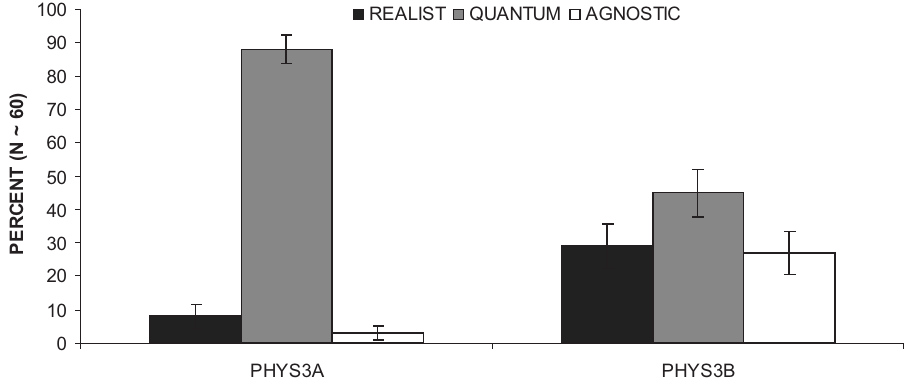
FIG. 6. Results for an essay question concerning interpretation in the double-slit experiment for each of the two modern physics courses (cid:1) N (cid:5) 60 for each course and error bars represent the stan- dard error on the proportion (cid:2) . See online supplement for additional data from